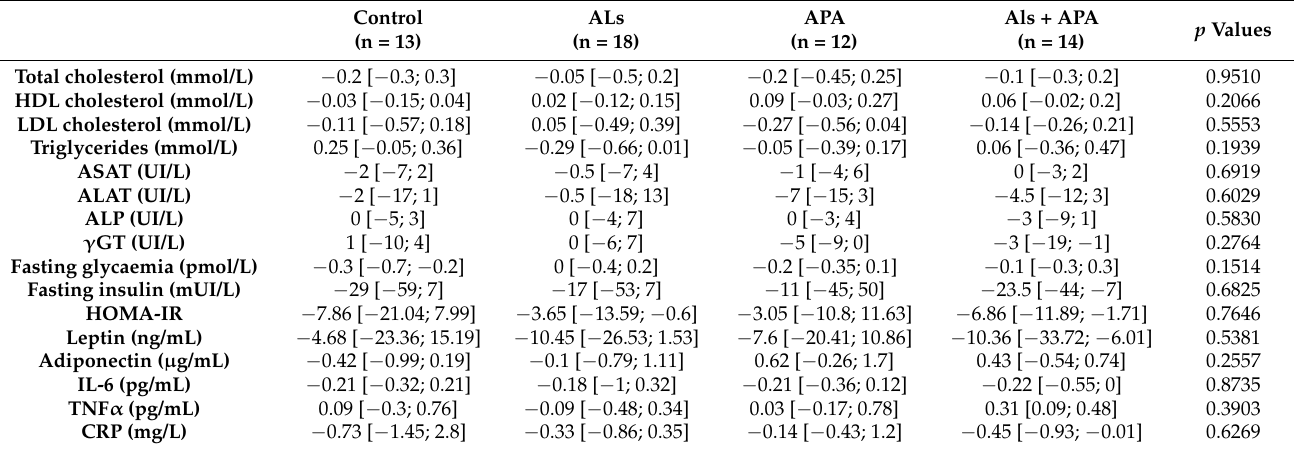
Table 3. Biological changes observed after 6 months of treatment: delta m0–m6.